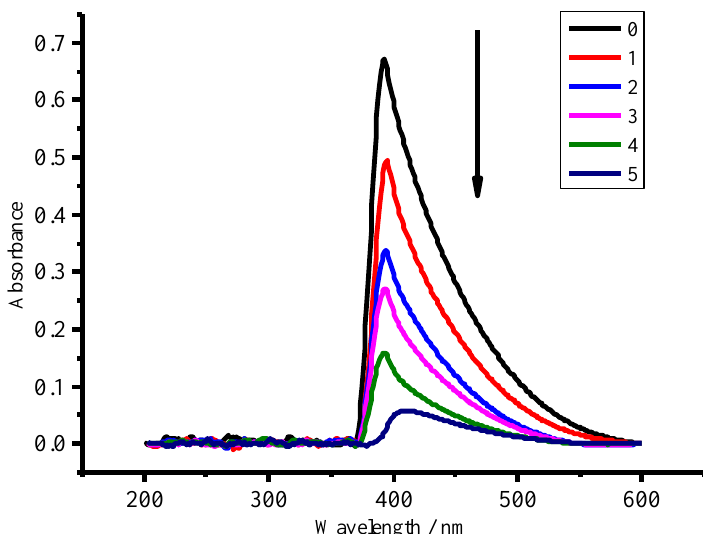
Figure 11. Ultraviolet-visible absorption spectra of ammonia solution during photocatalytic degradation process at 0, 1, 2, 3, 4, 5 h, respectively. Experimental conditions as follows: the concentration of ammonia-nitrogen, 100 mg/L; catalyst mass of CuFe 2 O 4 /NG, 0.1 g; solution volume: 50 mL with pH 9.5.